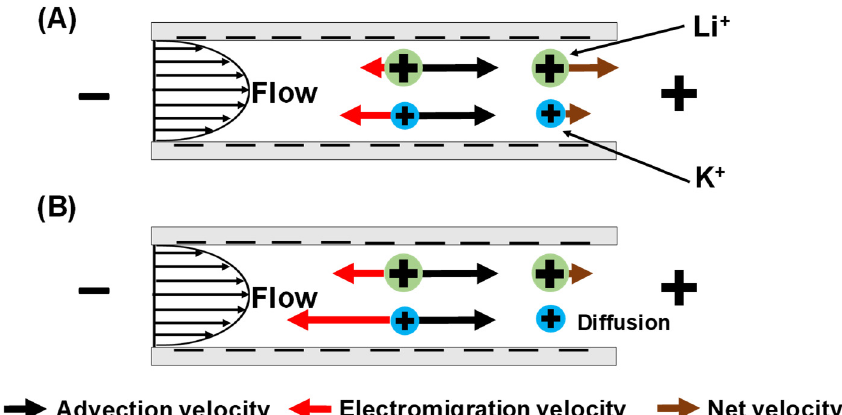
Figure 2. Scheme of Li + /K + separation during flow through a negatively charged nanopore: ( A ) elec- tromigration (red arrows) retards K + more than Li + due to the higher mobility of K + , whereas the advection velocities of both ions (black arrows) are the same; ( B ) with significantly strong streaming potentials, the magnitude of the K + electromigration velocity exceeds its advection velocity, and K + transports very slowly through the nanopore due to diffusion [24].